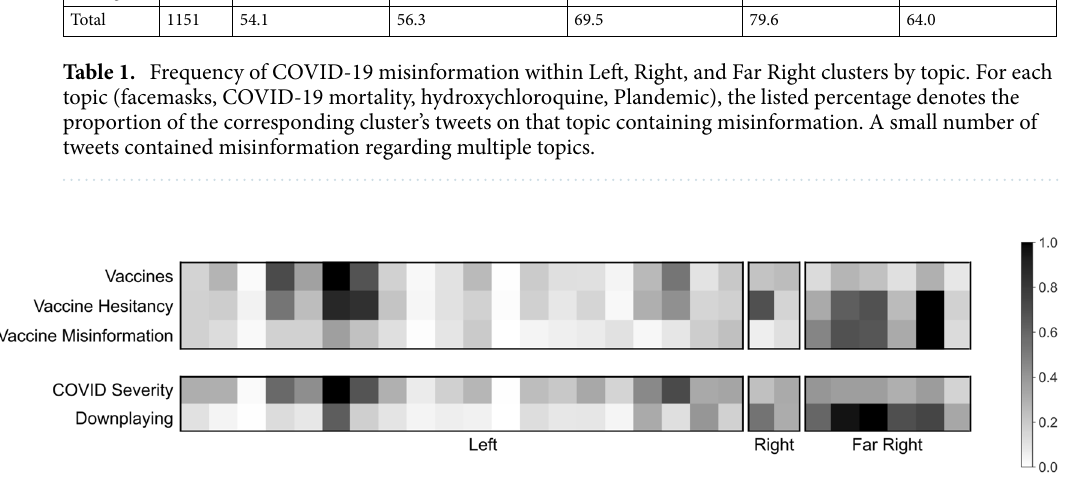
Figure 3. Distribution of topical tweets across communities. Grayscale corresponds to the percentage of the maximum within subtopic per capita tweet rate across communities. Per capita tweet rate corresponds to dividing the total number of topical tweets from each community by the number of active user days for the corresponding community. ‘Vaccine Hesitancy’ and ‘Vaccine Misinformation’ tweets are subsets of ‘Vaccines’ tweets; ‘Downplaying’ tweets are a subset of ‘COVID Severity’ tweets. Phrases used for topic identification are given in the Supplementary